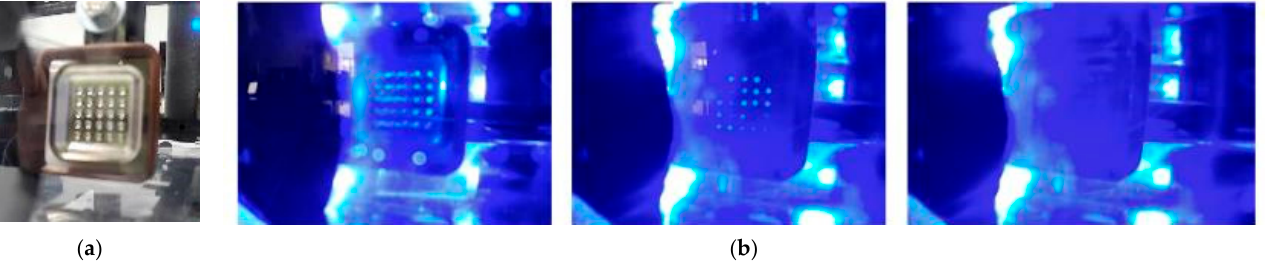
Figure 6. ( a ) Smartphone application´s image ( b ) Electroforming sequence seen from the surveillance system.